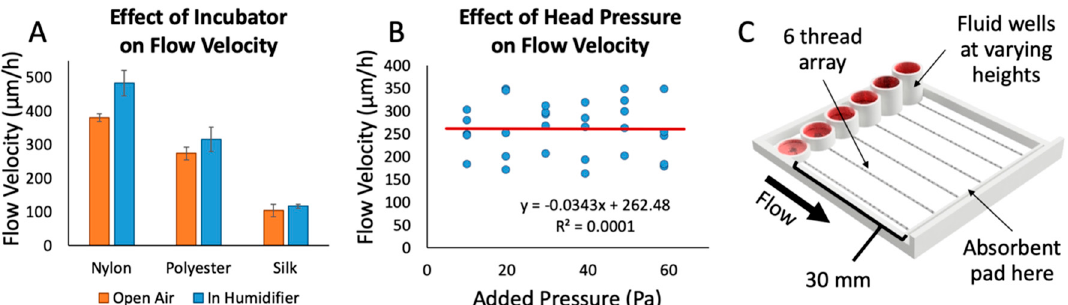
Figure 3. Factors a ff ecting fluid flow. ( A ) The e ff ect of incubator conditions (~97% humidity at 37 ◦ C) on flow velocity through various thread types, performed with red dye and the device shown in Figure 2B. The trend of a 5–20% increase in the average of flow velocities was not statistically significant (Student’s t -test, p -value of 0.067 (nylon), 0.75 (polyester), and 0.77 (silk)); n = 10 trials / strings per condition. ( B ) The e ff ect of added head pressure on flow velocity through various threads. The R 2 value of 0.0001 in the linear fit indicates that there is no correlation between flow velocity and head pressure up to 60 Pa (ranging from 1–6 mm fluid column height); n = 5 runs per pressure value. ( C ) 3D rendering of the test apparatus used to test the e ff ect of di ff erent head pressures on flow